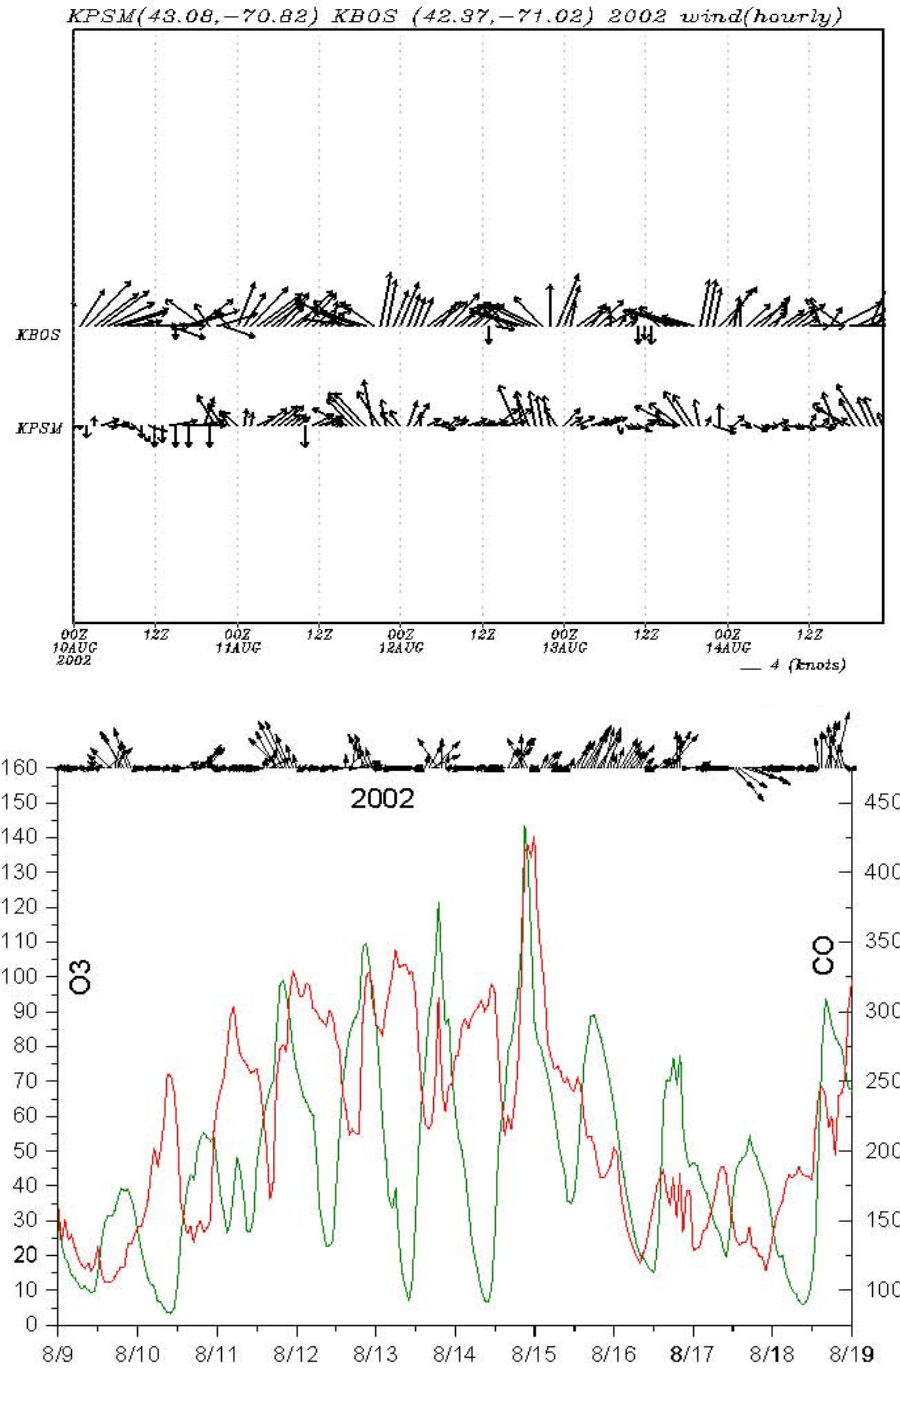
Figure 10. (Top) Local hourly wind observations from 10–14 August at KPSM and KBOS. X-axis is observational date from August 10 to 14; (Below) Hourly measurements at TF on 8/9~8/19 2002. Ozone is in green (use left axis), CO is in red (use right axis); and wind vector is in black (top line of the